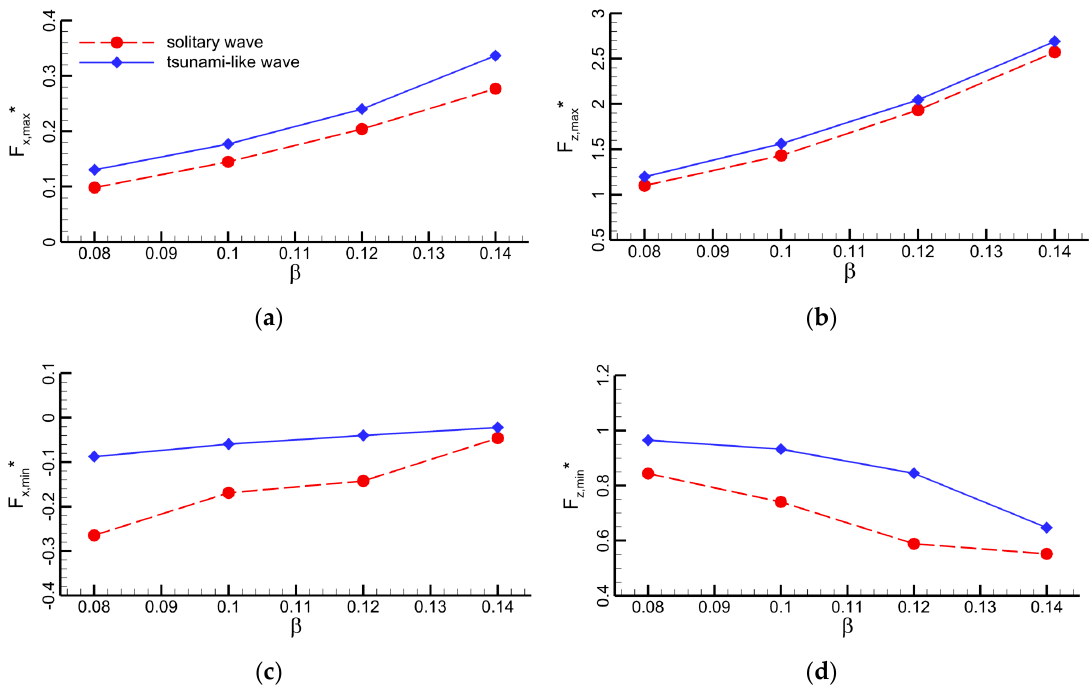
Figure 24. Plots of the maximum horizontal and vertical forces as function of pipeline diameter; ( a ) maximum horizontal force F x,max *; ( b ) maximum vertical force F z,max *; ( c ) minimum horizontal force F x,min *; ( d ) minimum vertical force F z,min *.